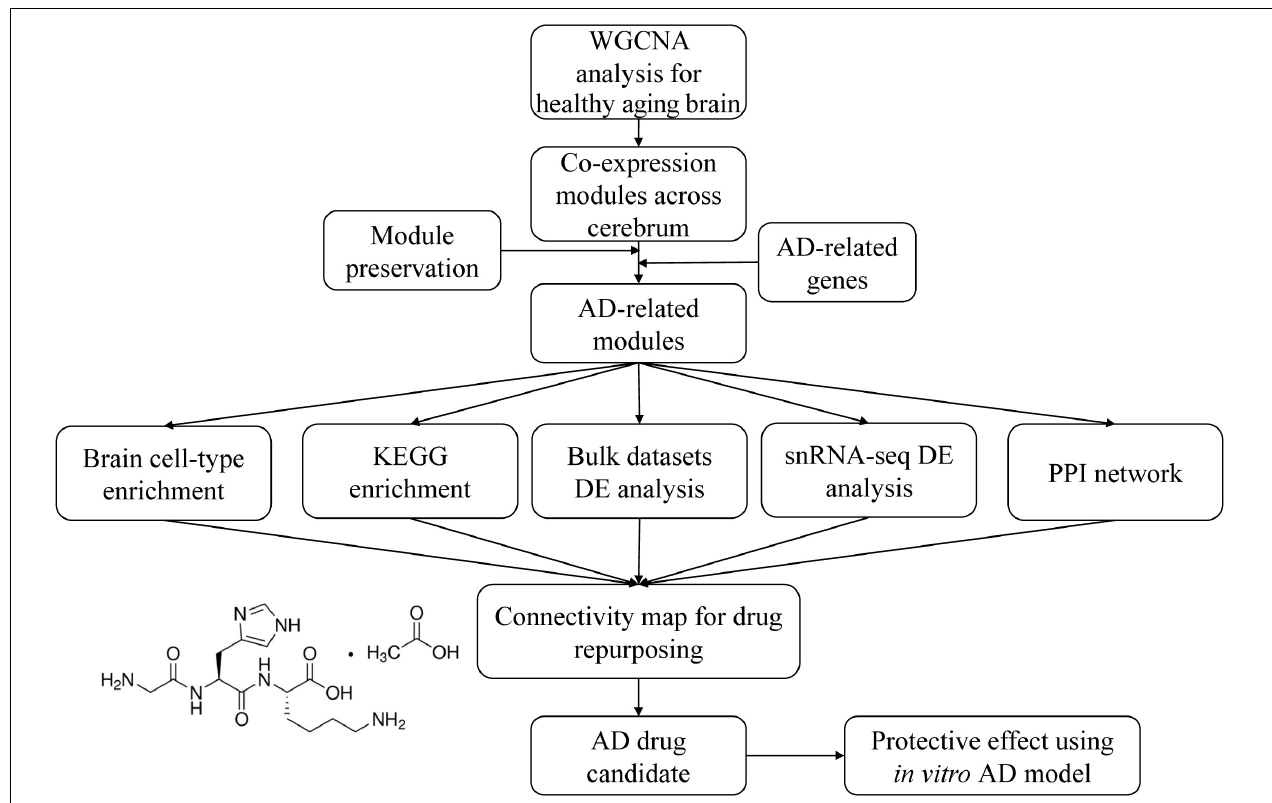
FIGURE 1 | Schematic design on how to discover Alzheimer’s disease (AD)-related modules and anti-AD drug